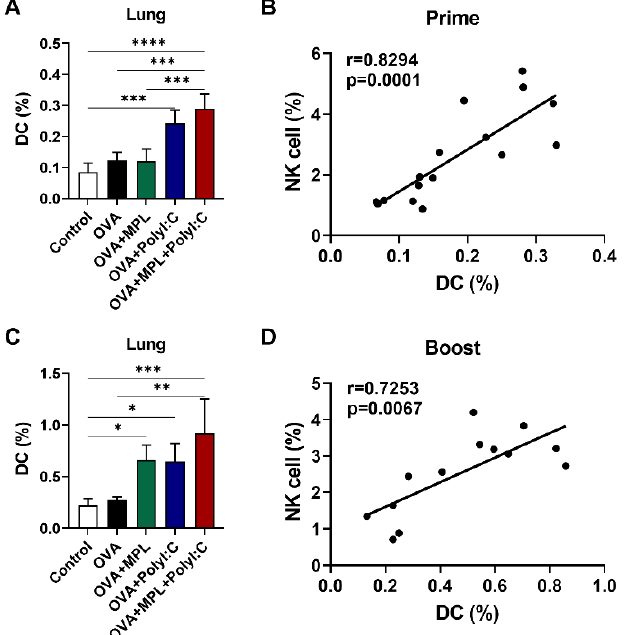
Figure 4. Correlation between DC and NK cell recruitment after intranasal immunizations of OVA with adjuvants. Lung samples of the immunized mice were harvested at day one prime ( A , B ) and boost ( C , D ) immunizations and then cell phenotypes were identified by flow cytometry. The frequencies of DC were analyzed as CD45 + F4/80 − CD11c + MHCII high population. The correlation of NK cell (Figure 1B,D) and DC frequencies were analyzed. The data show the mean ± SD. Statistical analysis between groups were performed by One-way ANOVA and Tukey’s multiple comparison test. * p < 0.0332, ** p < 0.0021, *** p < 0.0002 and **** p < 0.0001. For correlation analysis, Spearman’s rank correlation coefficients (r) and p value are calculated and shown.